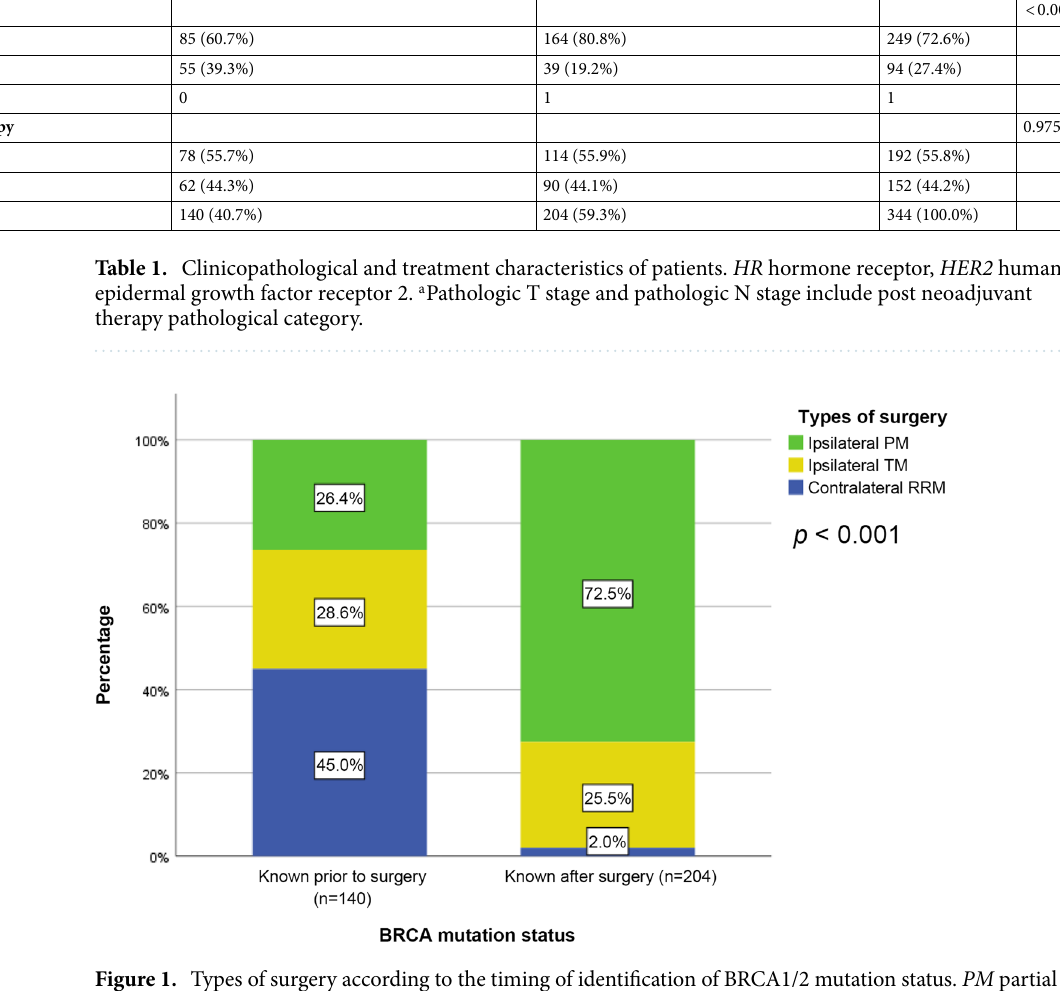
Figure 1. Types of surgery according to the timing of identification of BRCA1/2 mutation status. PM partial mastectomy, TM total mastectomy, RRM risk reducing